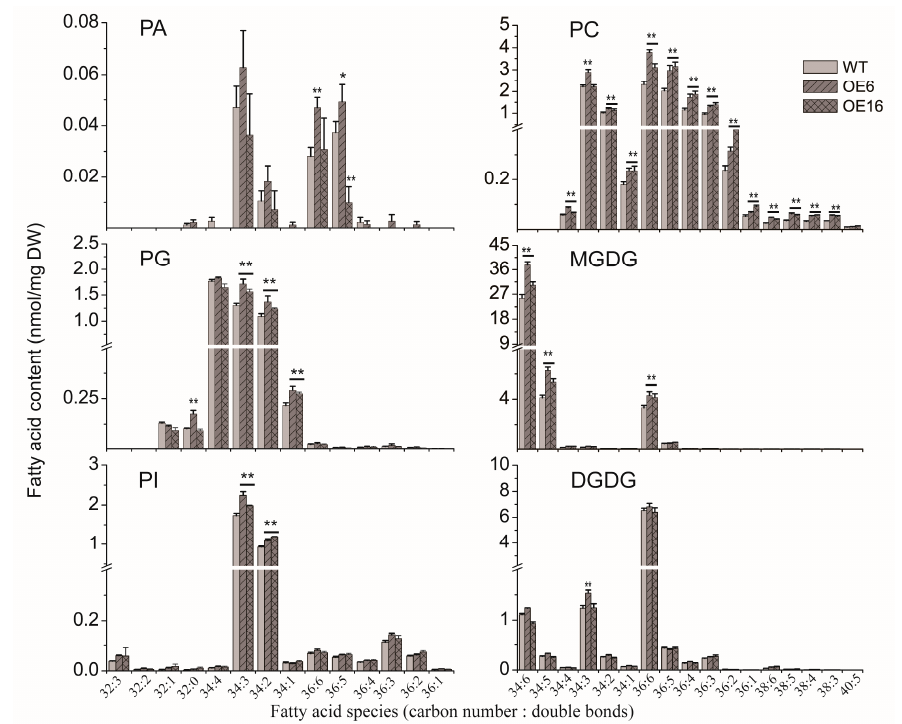
Figure 5. Effect of BnATS1 -overexpression on membrane lipid composition. Lipids were extracted from leaves of 40-day-old plants under field growth conditions. Fatty acid species are shown as total acyl carbons: total double bonds. Values are means ± SD ( n = 4 separate samples). * and ** denote significant di ff erence at p < 0.05 and p < 0.01, respectively, compared with WT plants based on Student’s t